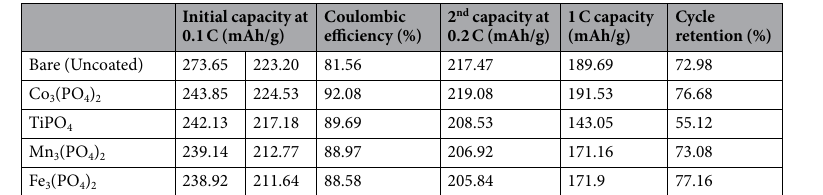
Table 1. Initial capacity at 0.1 C, Coulombic efficiency, 2 nd capacity at 0.2 C, at 1 C, and the cycle retention rates for uncoated and coated NCM